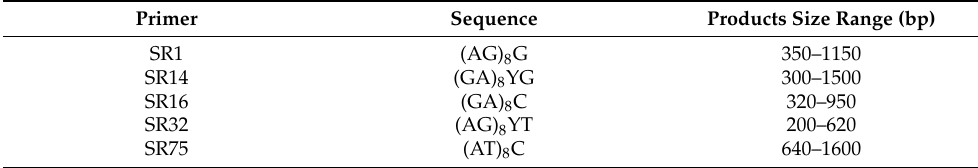
Figure 3. Plants obtained after six weeks of acclimatization after transplanting into P9 pots.